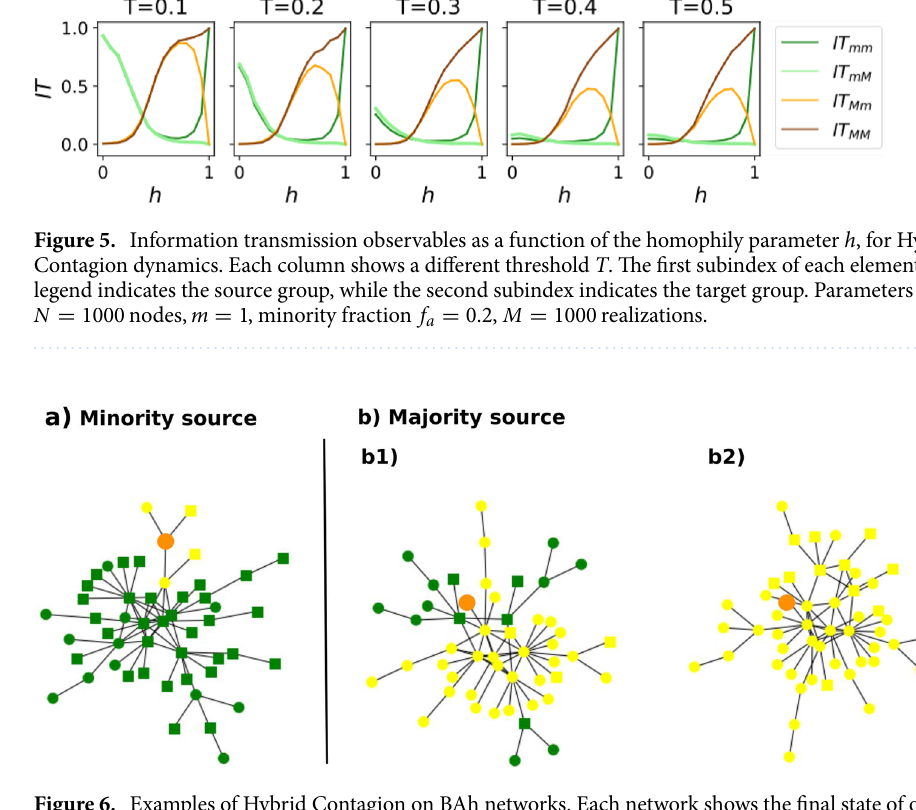
Figure 6. Examples of Hybrid Contagion on BAh networks. Each network shows the final state of one simulation, where green nodes are susceptible and yellow ones are informed. The orange node is the source of the information. Simple nodes are denoted by circles and complex nodes by squares. ( a ) When the source node belongs to the minority, Hybrid Contagion is limited. ( b ) However, when the source node belongs to the majority, a wide range of cascade sizes is obtained for the same parameters. Parameters used: N = 50 , h = 0.7 , f a = 0.2 , T = 0.2